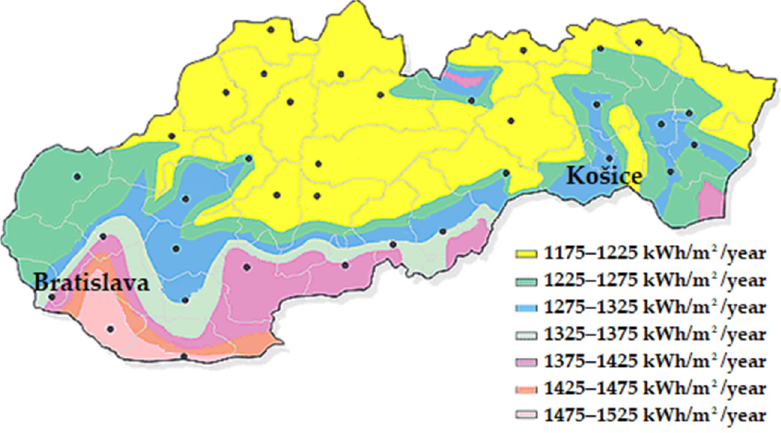
Figure 1. Solar map of SR with the intensity of sunlight